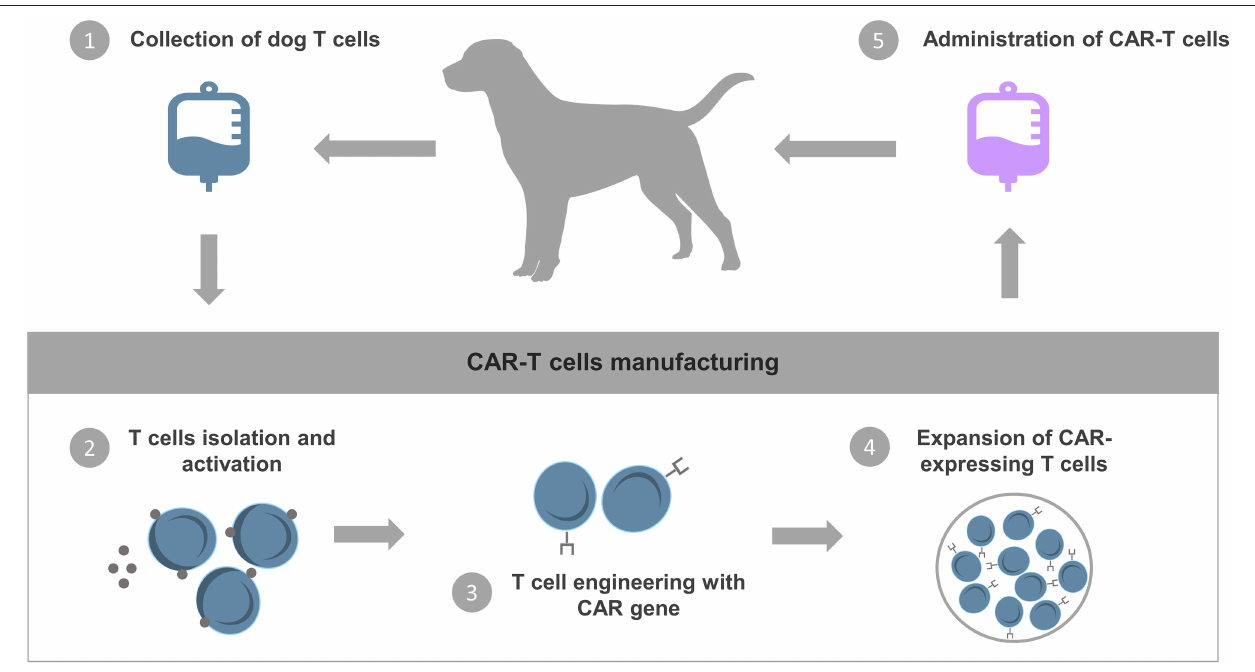
FIGURE 3 | CAR-T cells therapy. The basic procedures for CAR-T cell therapy start with the collection and extraction of T cells from the pet’s peripheral blood. The T cells are then genetically engineered in vitro to express chimeric antigen receptors (CARs) that can recognize specific tumor-associated antigens and activate self-proliferation and cytotoxicity. Finally, CAR-T cells are expanded and reinfused into the